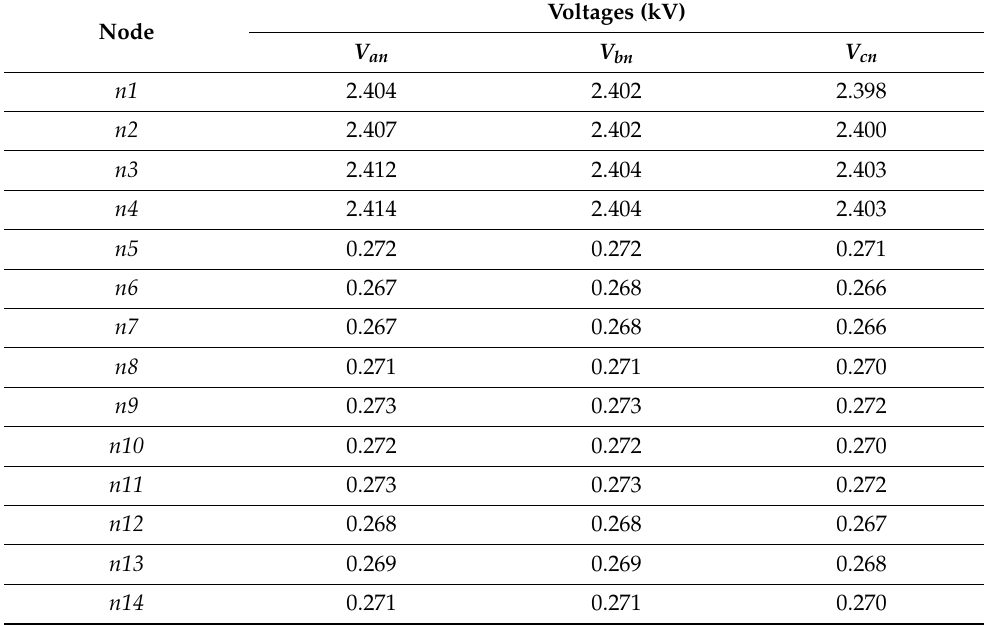
Table 3. Line-to-ground nodal voltage magnitudes with PRO